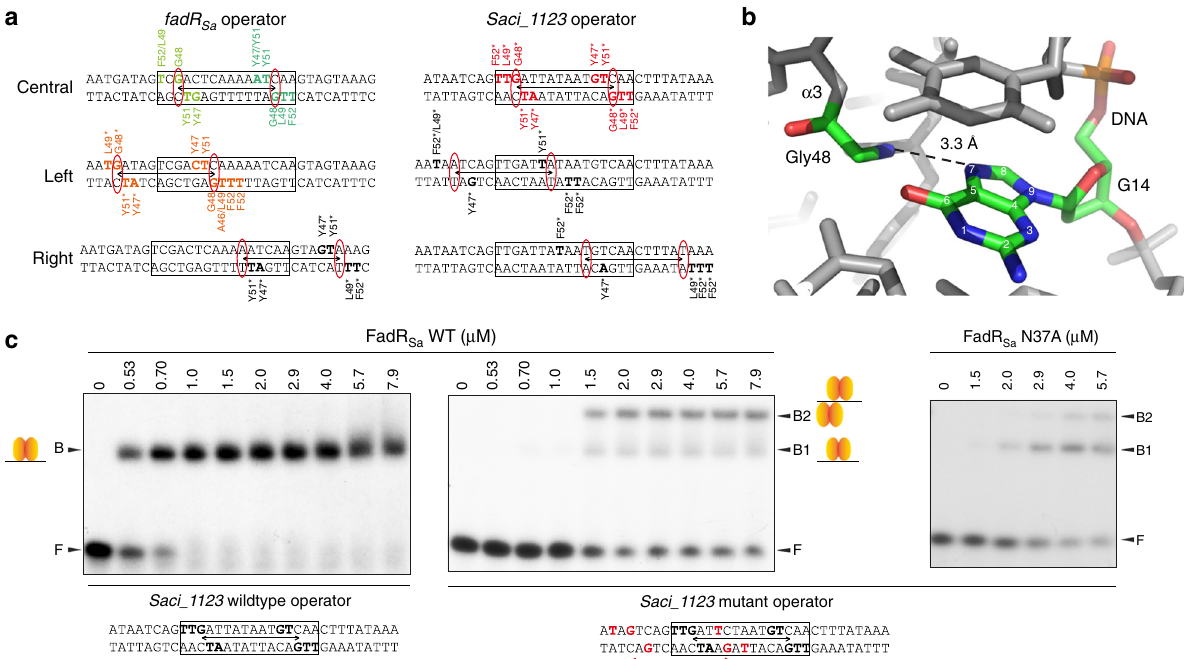
Fig. 5 Speci fi c protein – DNA contacts determine stoichiometry of the interaction. a Map of observed and hypothesized interactions for the fadR Sa and Saci_1123 operators. Colored base and amino acid residues without an asterisk represent contacts identi fi ed in the FadR Sa – DNA cocrystal structure (using the same color code for the subunits as in panel ( a )). Colored residues with an asterisk are hypothesized to be established in the natural operators. Black residues in bold are those that theoretically could support binding in case a GC (AT) or CG (TA) would have been present on the crucial Gly48-interacting positions, which are indicated with red ovals. b Zoom of the Gly48 – G14 interaction in the interface between subunit E and the X – Y DNA duplex in the FadR Sa – DNA cocrystal structure. c EMSAs with 45-bp DNA fragments representing a wildtype or mutated variant of the Saci_1123 operator region, performed with wildtype or N37A mutant FadR Sa . Molar protein concentrations are shown above the autoradiograph, whereas populations of free DNA (F) and FadR Sa – bound DNA (B, B1, and B2) are indicated with an arrowhead, as well as with schematical representations of the binding